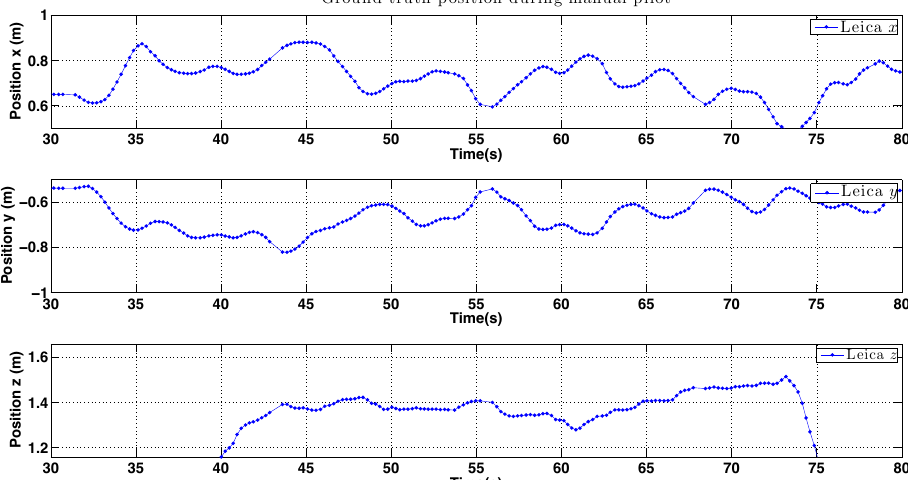
Figure 36. Experimental results for Pilot 2 during manual hovering: position versus time.